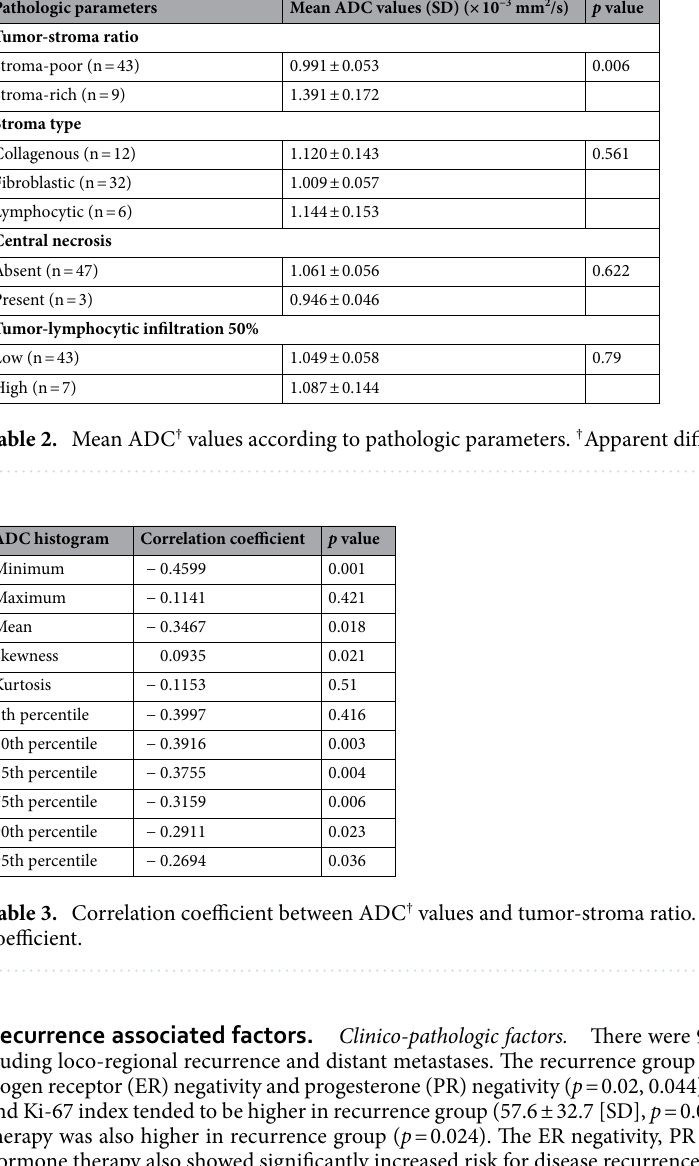
Pathologic parameters